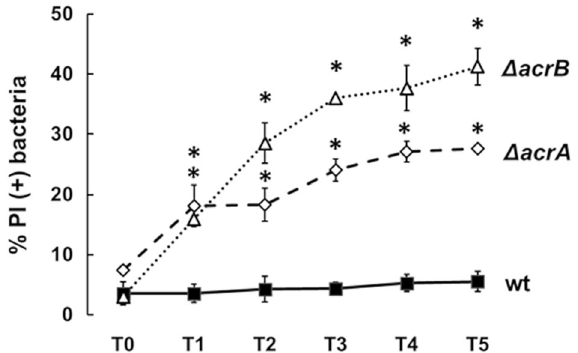
Figure 2. Both the AcrB and AcrA components contribute to survival of LF82 within macrophages. Intracellular LF82 (black square), LF82 ΔacrB (open triangle), and LF82 ΔacrA (open diamond) bacteria were recovered from THP-1 differentiated into macrophages at 0, 1, 2, 3, 4 and 5 h p.i. (referred to as T0, T1, T2, T3, T4 and T5, respectively) and stained with DAPI/PI. The values are expressed as percentage of PI (+) dead bacteria relative to DAPI (+) bacteria. The results are the average of at least three independent experiments. Error bars represent the SD. The statistical significance was determined by a two tailed student’s t test. *p ≤